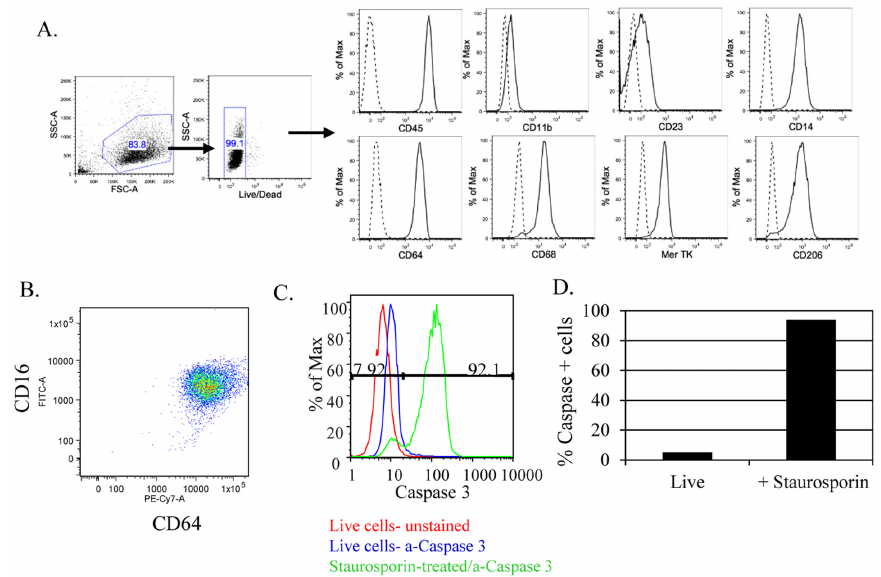
Fig 1. Characteristics of SelecT generated macrophages and apoptotic status of staurosporine- treated cells. Macrophages were prepared by culture with M-CSF as described in materials and methods. Following treatment with IFN- γ , the majority of macrophages express markers found on both M1 and M2 populations (A). Cells were gated by scatter then expression of markers was assessed on live cells. M1-M2 intermediate phenotype macrophages are CD64 + CD16 + (B). Jurkat cells were treated with staurosporine for 3 hours at 37°C as described in materials and methods. Cells were stained for active caspase 3 then quantitated using flow cytometry (C) or stained with Magic Red then measured using high content imaging